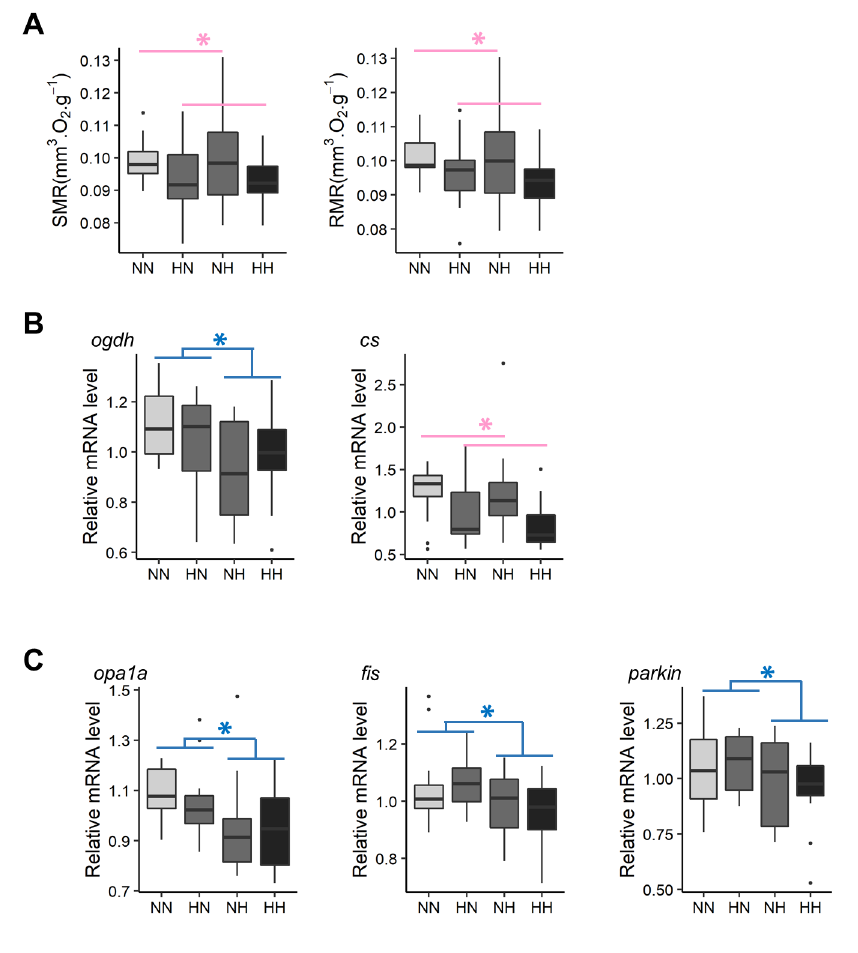
Figure 4. Effect of parental HC/LP on fry metabolism and, in particular, ( A ) on fry metabolic rates, ( B ) relative mRNA levels of genes related to energy production, and ( C ) relative mRNA levels of genes involved in mitochondrial dynamics. The effect of maternal nutritional history is depicted in red and the effect of paternal nutritional history in blue (”*” means p -value <